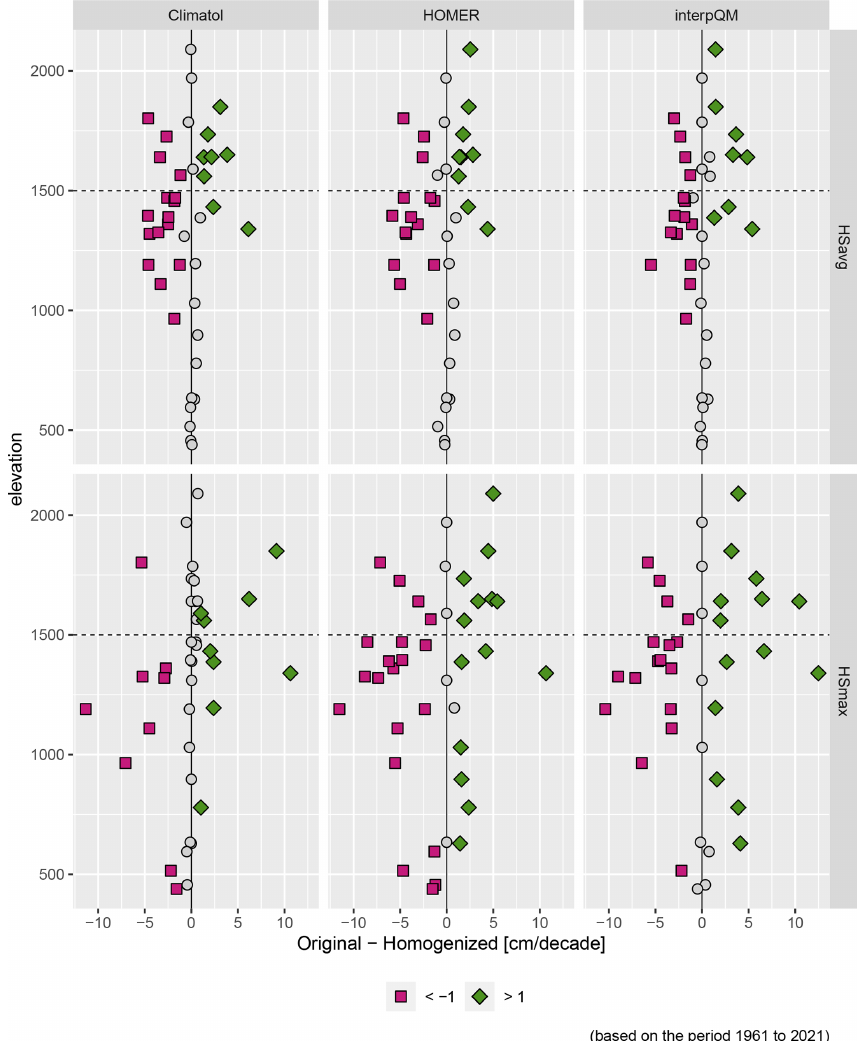
Figure A3. Comparison of differences of trends calculated with Climatol, HOMER, and interpQM for the period 1961–2021 for HSavg and HSmax. Differences are calculated as original − homogenised. Purple squares indicate stations with a result of < − 1, green diamonds >